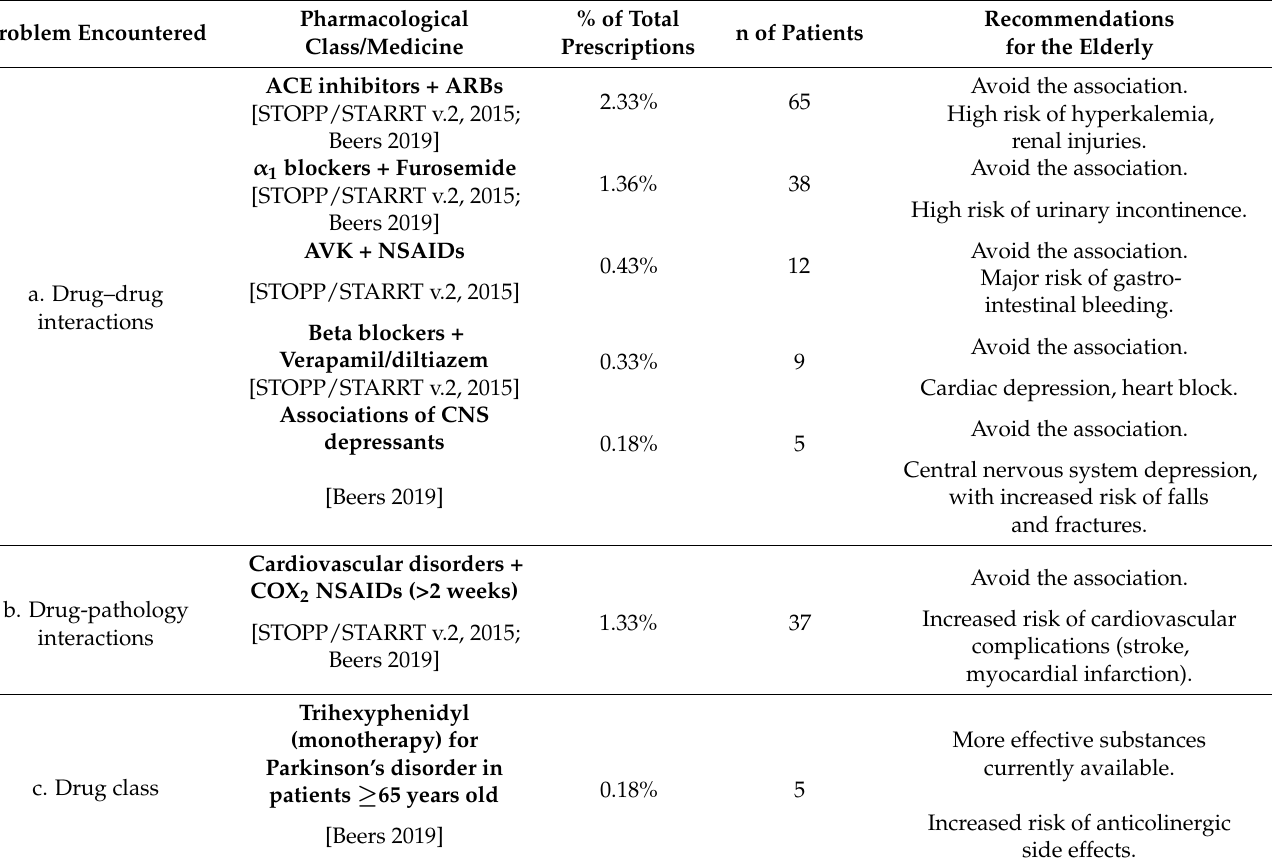
Table 4. Misuse of medicines according to STOPP/START v.2, 2015 and Beers 2019 Criteria [26,27]. Problem